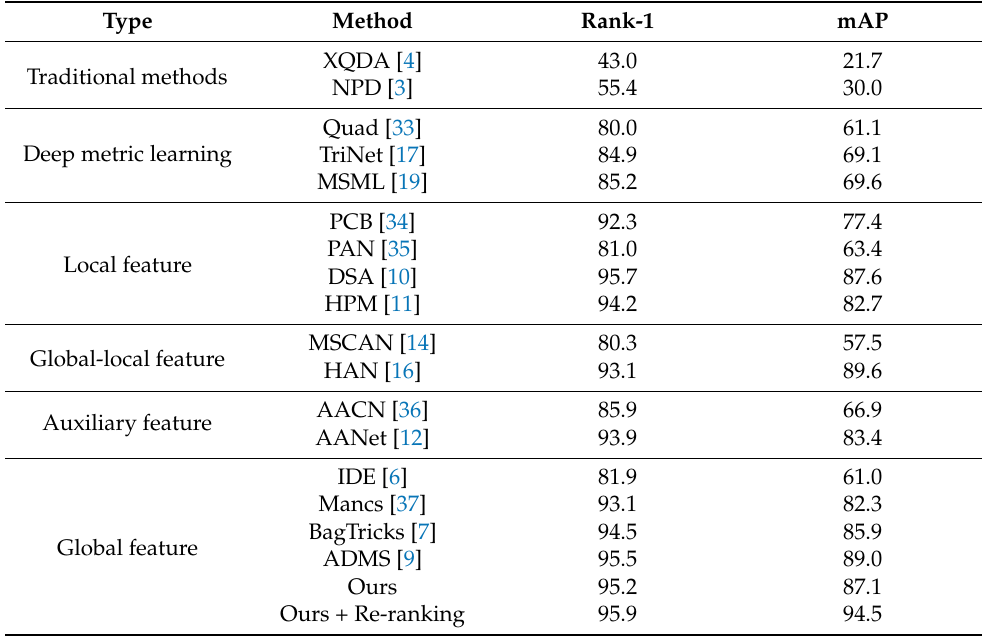
Table 4. Comparison of the results of different methods under the Market1501 dataset.